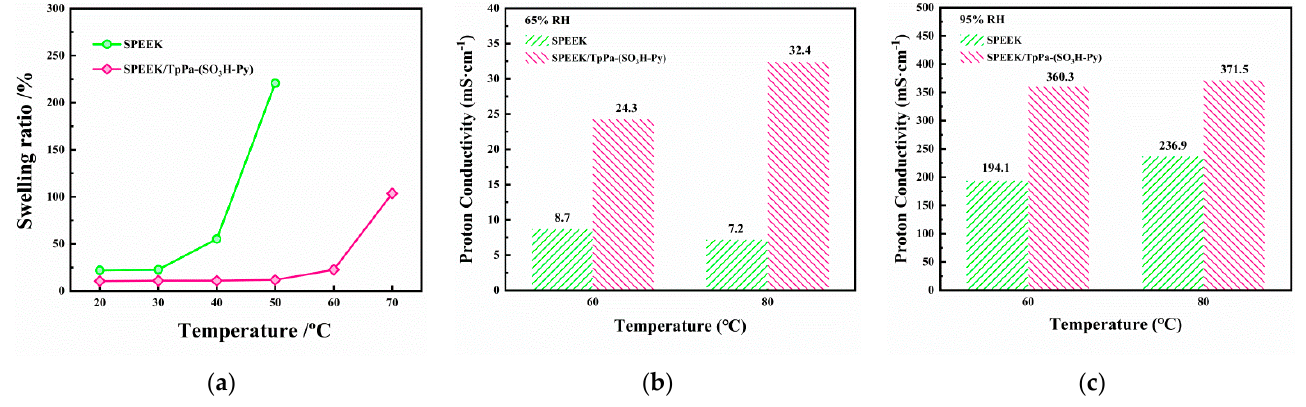
Figure 9. ( a ) Swelling of SPEEK and SPEEK/TpPa − (SO 3 H-Py) from 20 °C to 70 °C at 100% RH; proton conductivity at ( b ) 65%RH and ( c ) 95%RH of TpPa − (SO 3 H-Py).